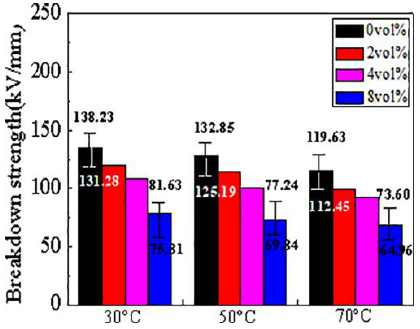
Figure 9. The breakdown strength of CCTO/EPDM composites.